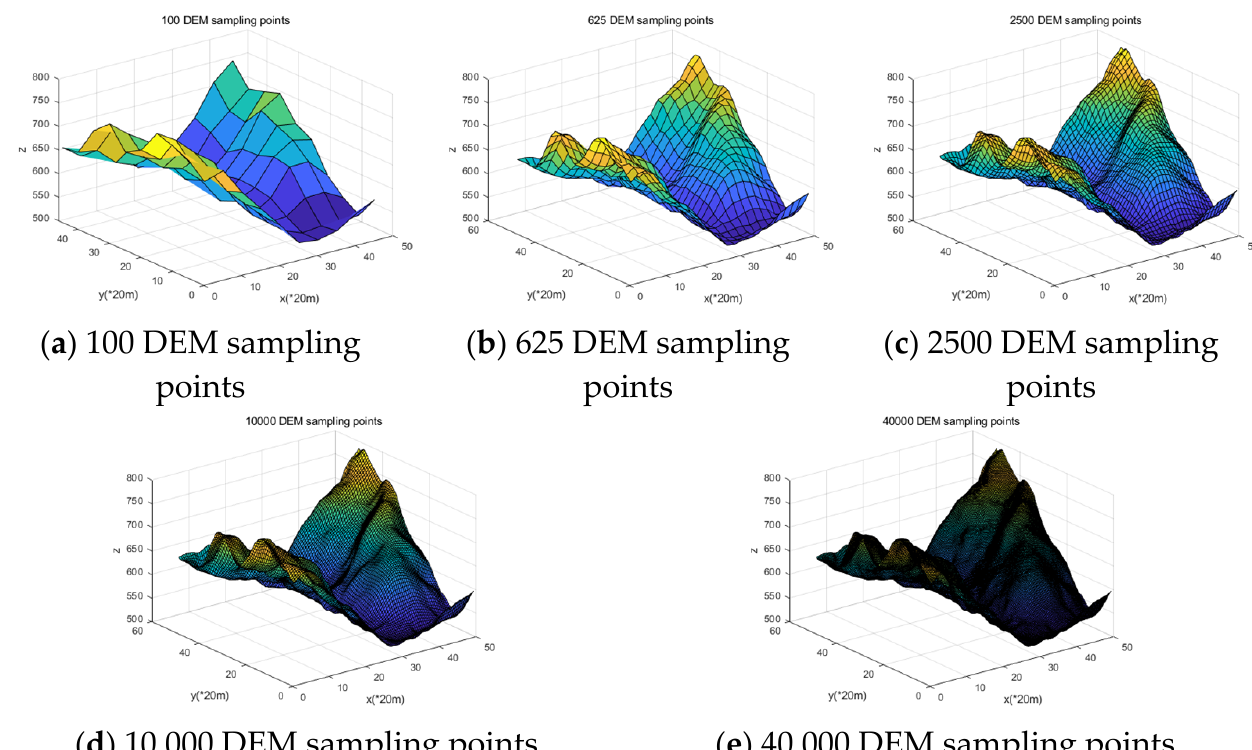
Figure 2. Comparison of DEM data volume and modeling accuracy.